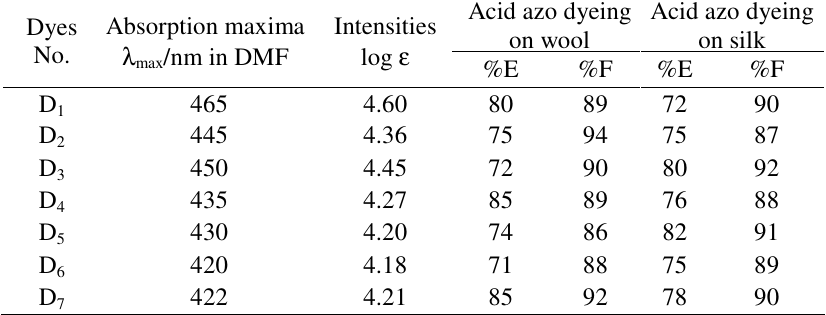
Table 1. Absorption maxima ( λ acid azo dyes on wool and silk.